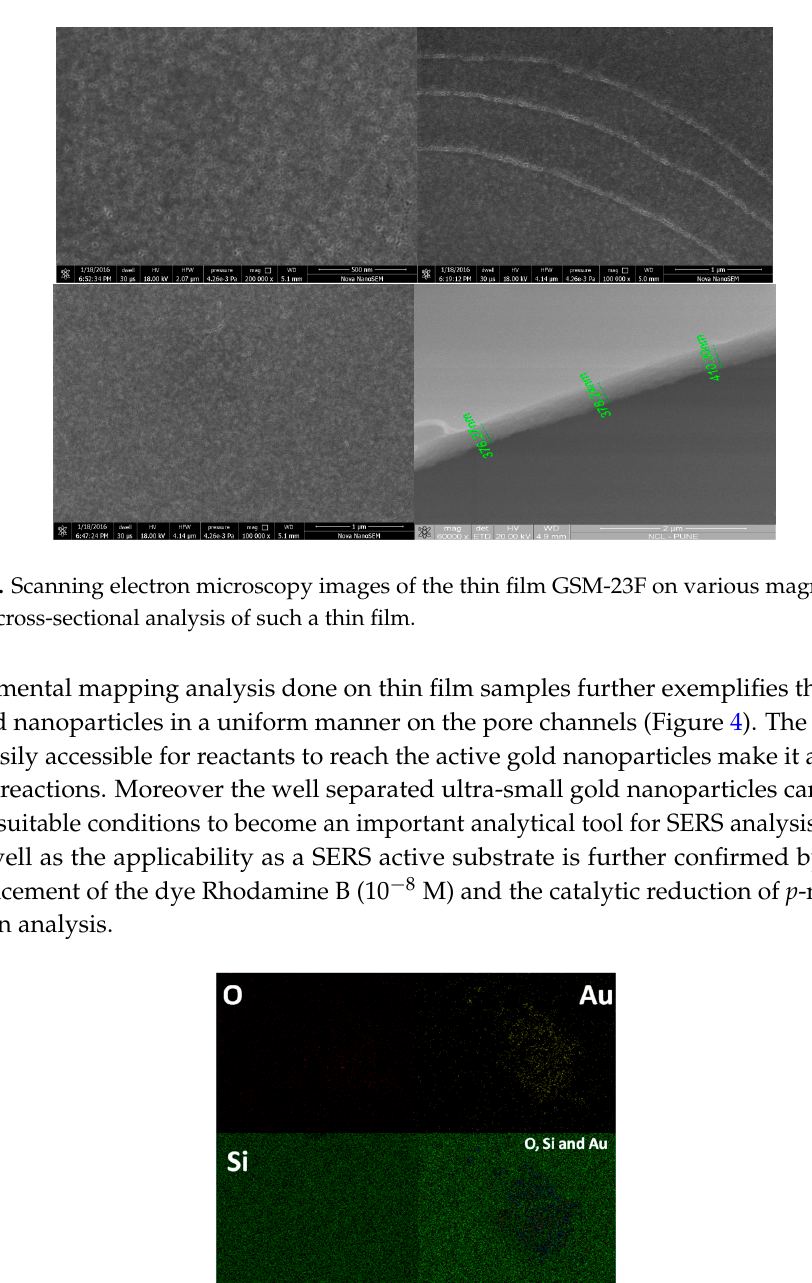
Figure 4 . Elemental mapping of the GSM-23F thin film done under scanning electron microscope .